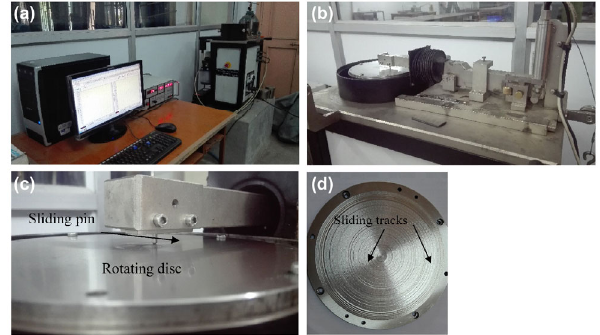
Fig. 2 (a) Pin-on-disc experimental setup; (b) pin and disc machine; (c) closed view of sliding in on rotating disc; (d) sliding tracks on rotating disc.